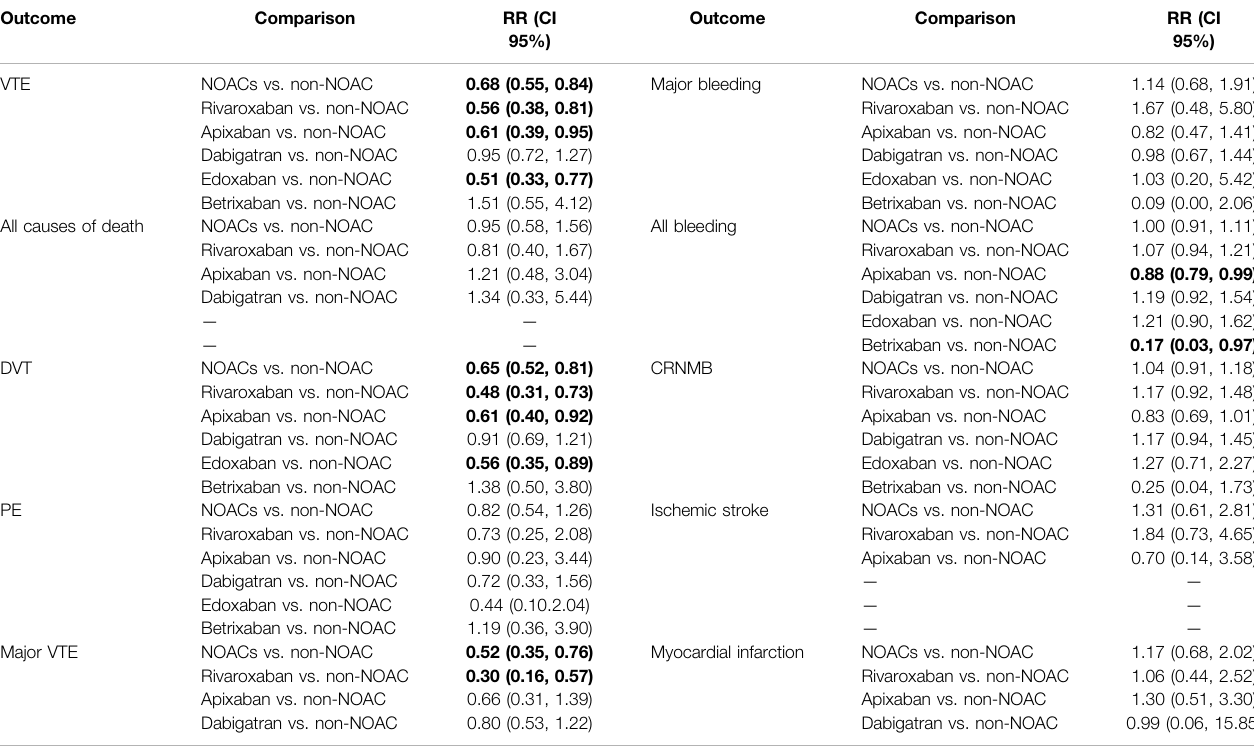
TABLE 2 | Forest plot results of any NOAC against non-NOAC in THA and TKA patients Outcome